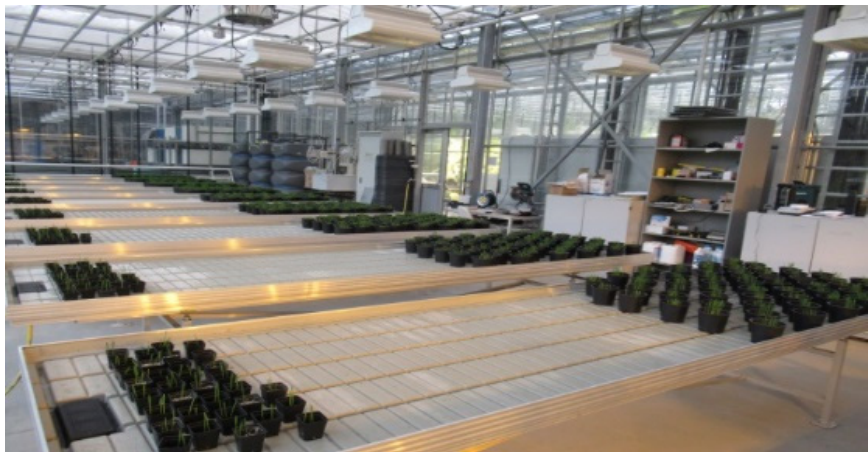
Figure 2. Hydroponics section of the FishGlassHouse with a view of T. aestivum on ebb-and-flood tables in cabin 1.04 at the beginning of the experiment.